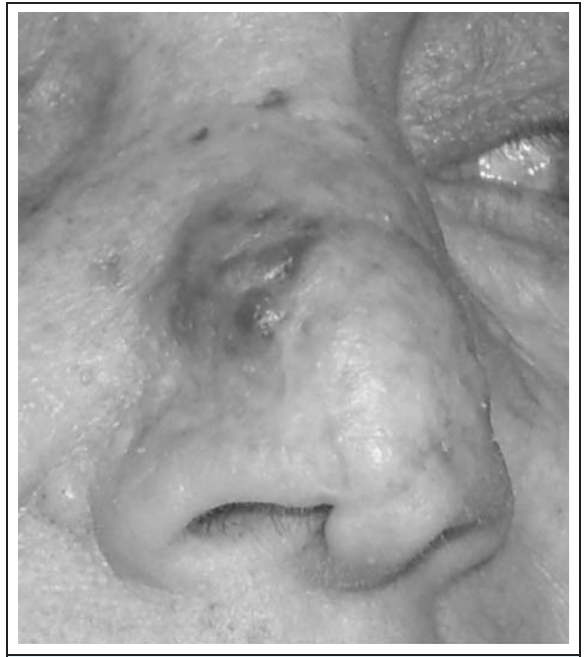
Figure 1. Close up view of the violaceous fl eshy no- dular lesion on the